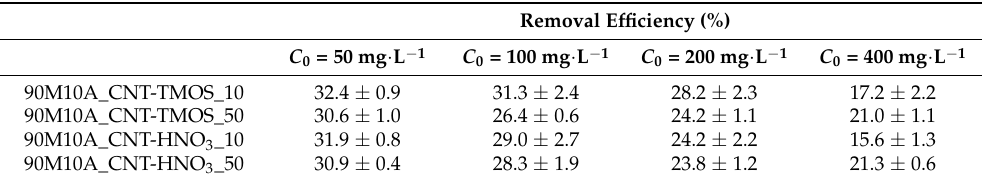
Table 5. Removal efficiency of the carbon nanotubes–silica aerogel composites with two amounts of carbon nanostructure for different initial concentrations of